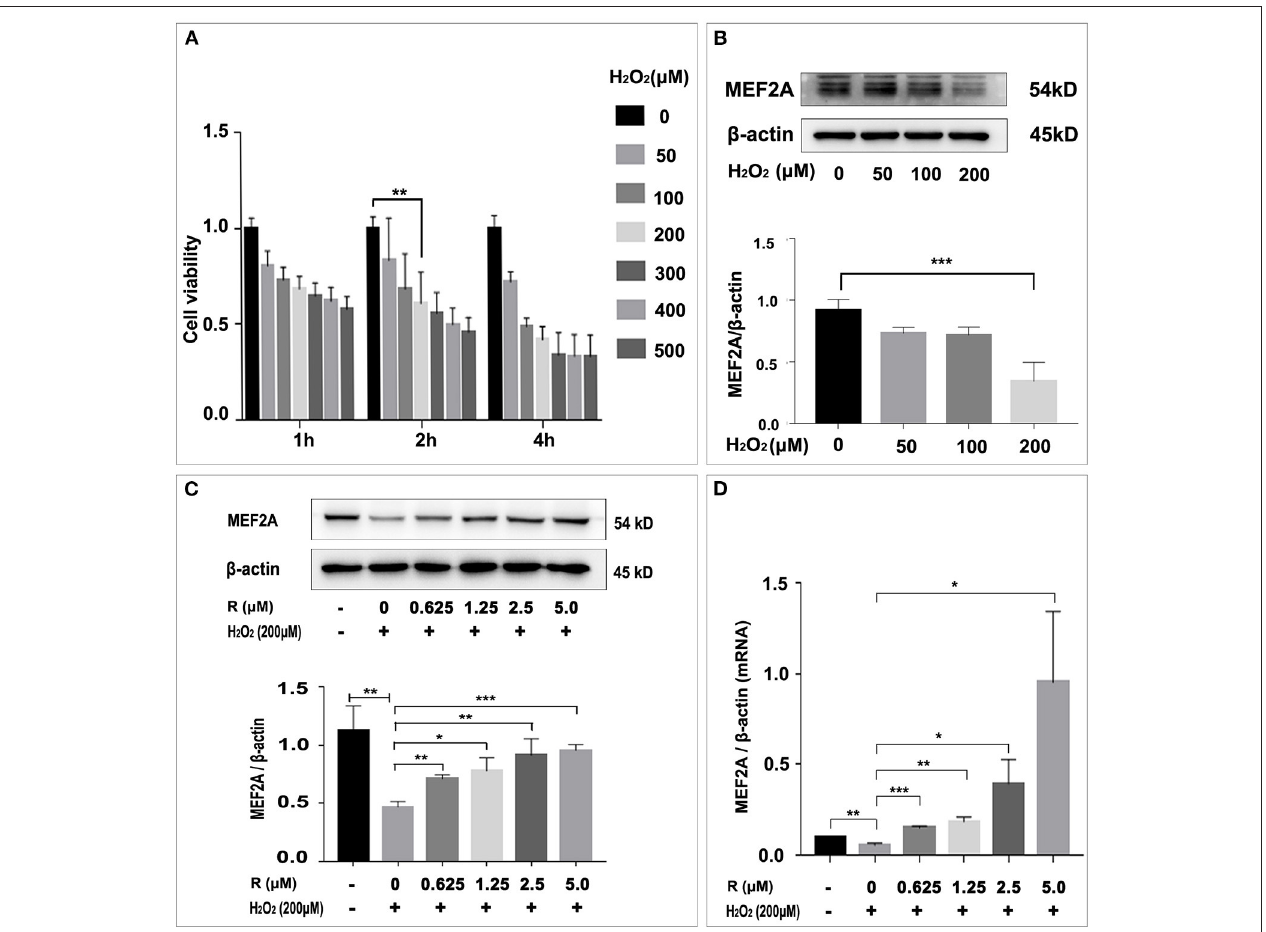
FIGURE 2 | Influence of H 2 O 2 on cell viability and resveratrol rescue MEF2A from the down-regulation induced by H 2 O 2 . (A) Effect of treatment of HUVEC with gradient concentration of H 2 O 2 for various time on viability. (B) Immunoblots of MEF2A in HUVEC treated with gradient concentration of H 2 O 2 for 2h. (C) Expression of MEF2A proteins in HUVECs that were pretreated with gradient concentration of resveratrol for 24h followed by treatment with H 2 O 2 (200 µ M for 2h). β -actin was used as a loading control. Quantification of band intensity was performed via image-J and values were normalized to that of beta-actin. (D) The mRNA level of MEF2A in HUVECs that were pretreated with gradient concentration of resveratrol for 24h followed by treatment with H 2 O 2 (200 µ M for 2h). β -actin was used as the internal control to normalize the MEF2A mRNA level. All experiments were performed independently for three times. Mean ± SD is represented as bar plot. The statistical significance is analyzed by the unpaired Student’s two-tailed t -test. ns, no significance; * P < 0.05; ** P < 0.01; *** P < 0.001 between groups indicated. caused by si-MEF2A could not be reversed by treatment